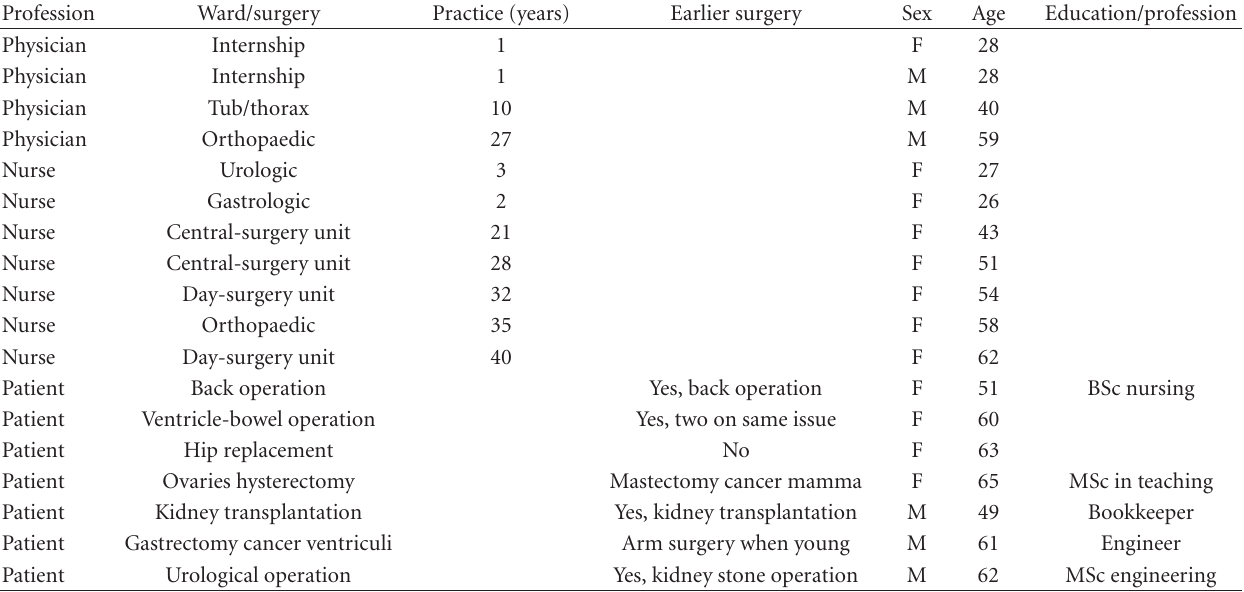
Table 1: Participants